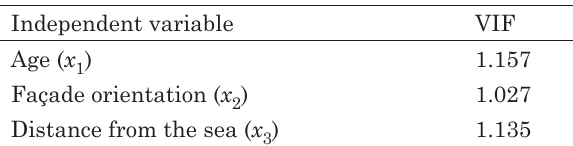
Table 8. VIF (variance inflation factor) values for each explanatory variable of the proposed model